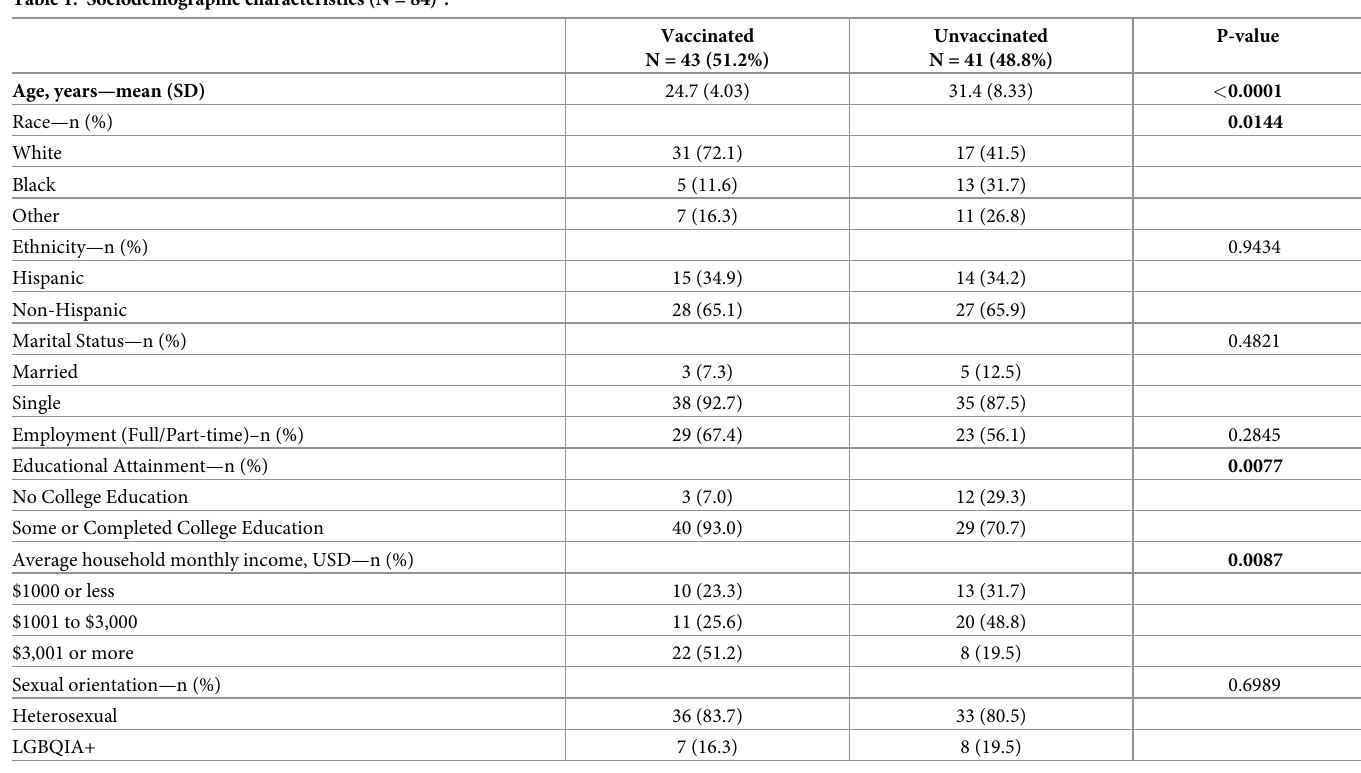
Table 1. Sociodemographic characteristics (N = 84) a